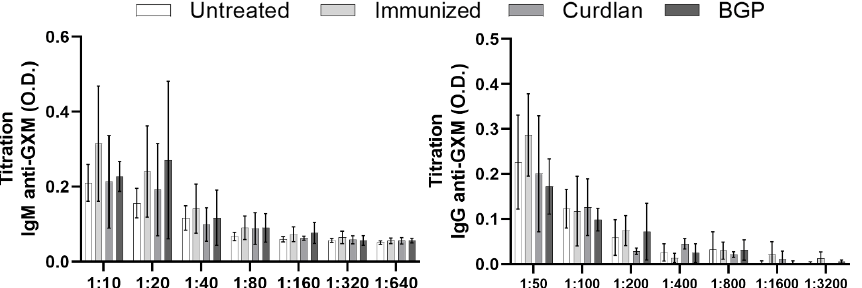
the untreated and HK- C. gattii -thin-only treated groups, respectively (Figure 10C,E). Fi- nally, the pro-inflammatory cytokines induced by administration of the Dectin-1 ligands were associated with high levels of IL-10 in the lung tissue of C57BL/mice.